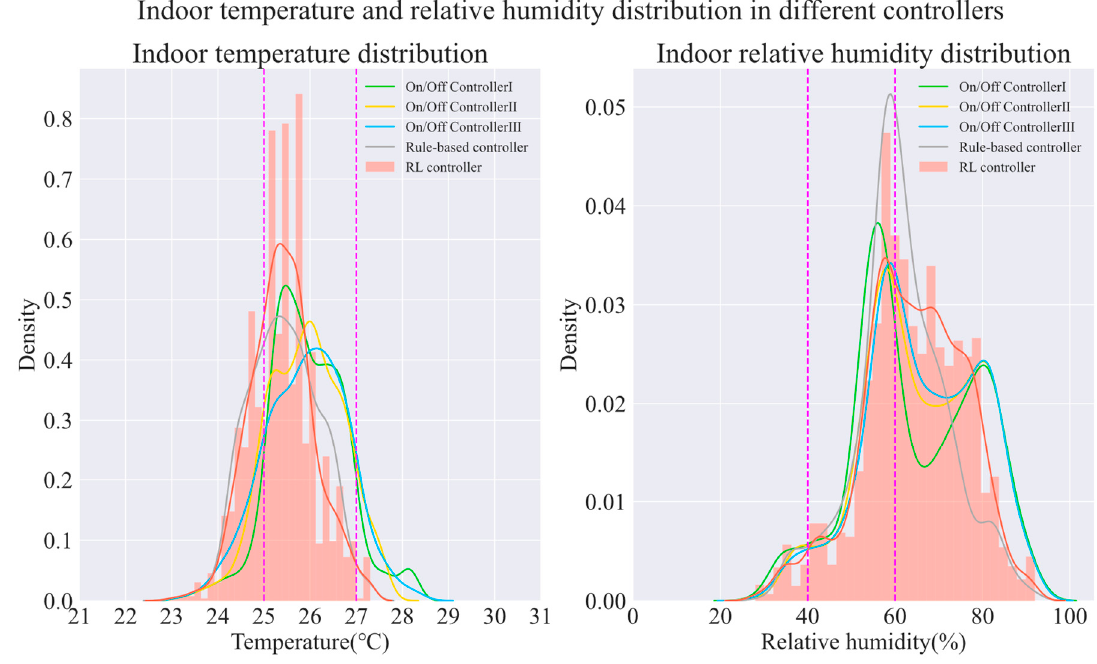
Figure 11. Indoor temperature and relative humidity distribution in different controllers.